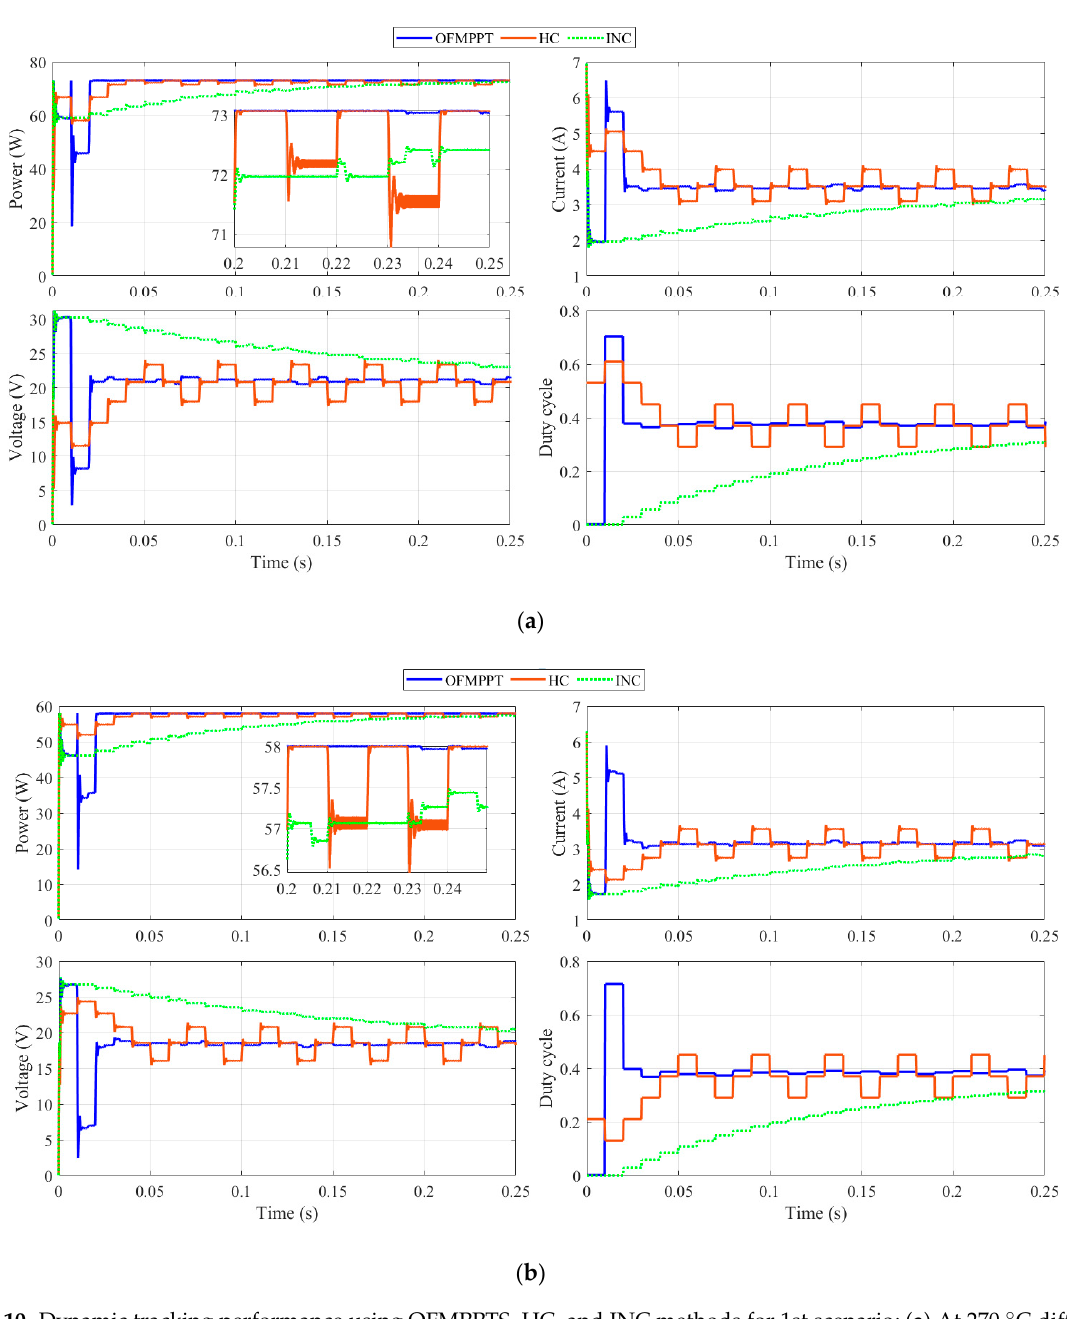
Figure 10. Dynamic tracking performance using OFMPPTS, HC, and INC methods for 1st scenario; ( a ) At 270 °C difference temperature; ( b ) At 220 °C difference temperature.